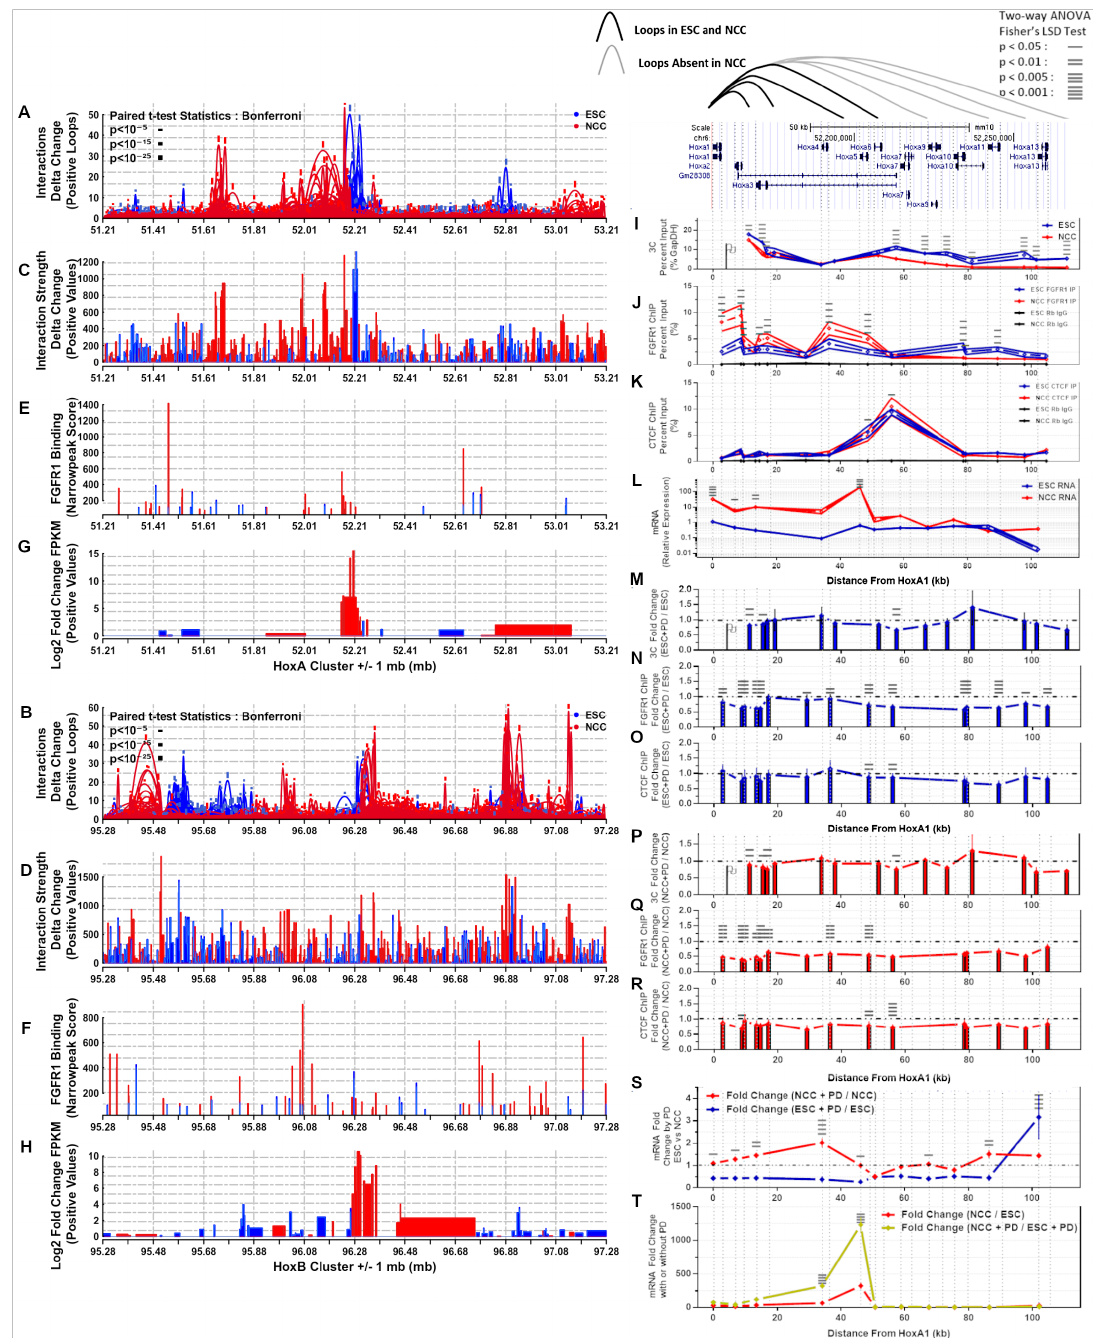
Figure 3. Downregulated TADs express stage specific genes and are reorganized during ESC to NCC — — differentiation. At interacting (q<0.001) upregulated and downregulated anchor-anchor midpoints: (A) — — Differential gene expression. (B) TAD overlap. (C) Directionality Index. (D) Gene Ontology Category — — Enrichment. Two-way ANOVA Tukey Method: ESC versus NCC for each location shown, p<1e-2 — . ( C , D ) Differential interaction anchor p<1e-4 ; p<1e-6 ; p<1e-8 ; p<1e-10 . At TAD borders aligned left and right based on regulated ; gene directionality (adjusted p<0.05): (E) TAD reorganization. (F) Differential gene expression. (G) — — Differential interaction anchor strength. (H) Differential nFGFR1 binding. (I) Differential gene coding — — and regulator feature enrichment. Z-Score statistics indicate bins which are outside the mean of all bins — — p<0.05 ; p<0.01 ; p<0.005 . (J) Differential chromatin looping. (K) Differential nFGFR1 looping.